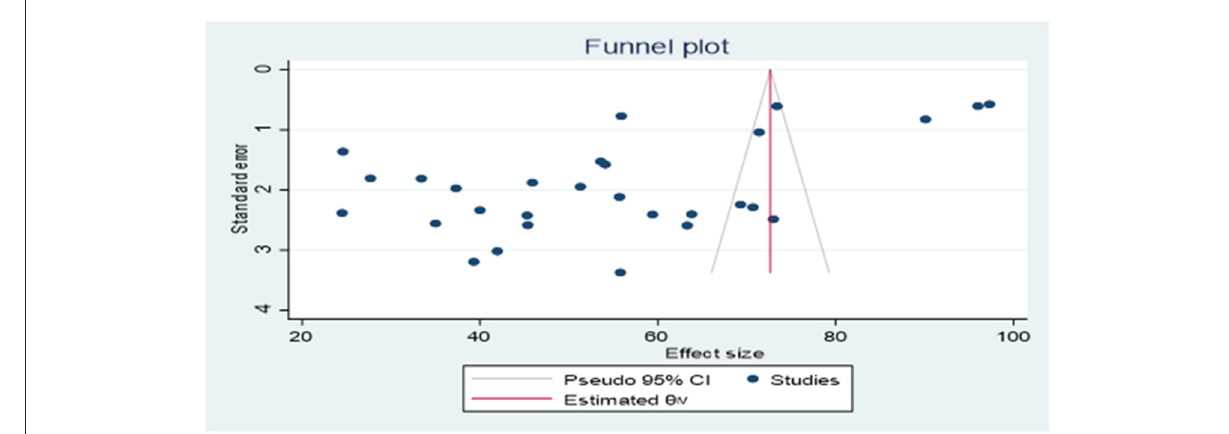
FIGURE3 Assessment of publication bias.